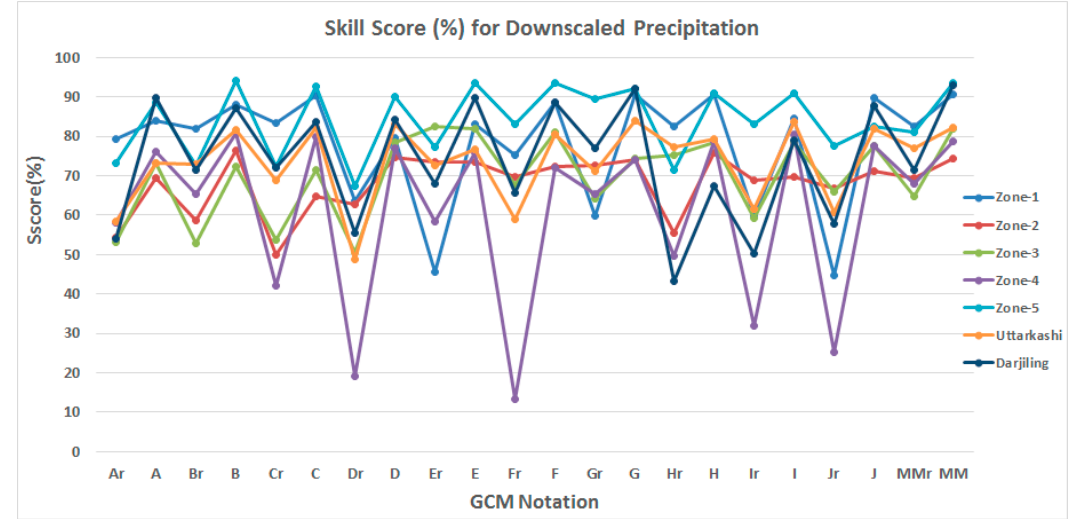
Figure 15. Skill Scores (%) of Re-Obs and GCM-Obs models for downscaling precipitation with different GCMs. GCM notations are same as the ones used in Figure 8. Water 2019 , 11 , x FOR PEER REVIEW